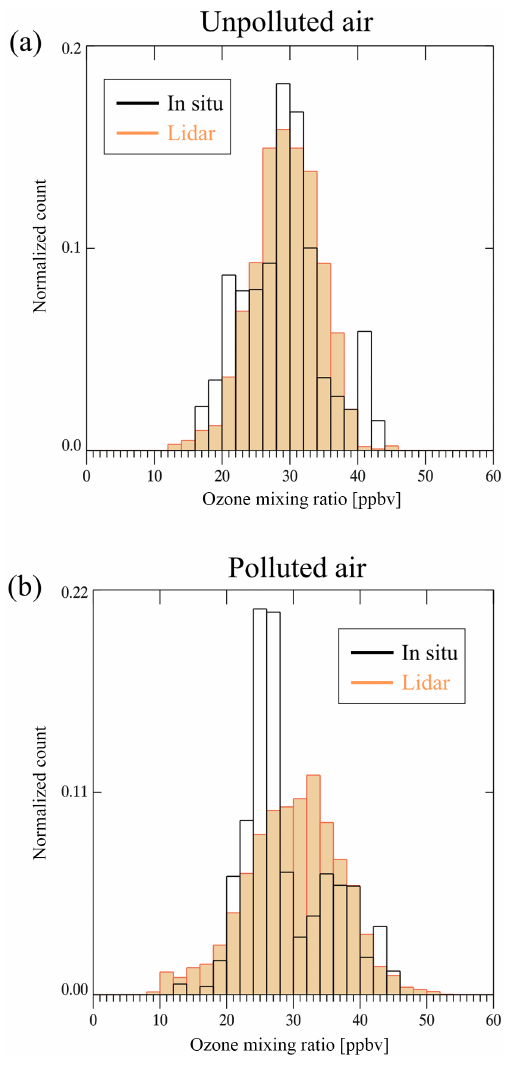
Figure 16. Histograms of in situ and lidar-derived O 3 mixing ratio for the measurements taken within the boundary layer in (a) unpol- luted air and (b) polluted